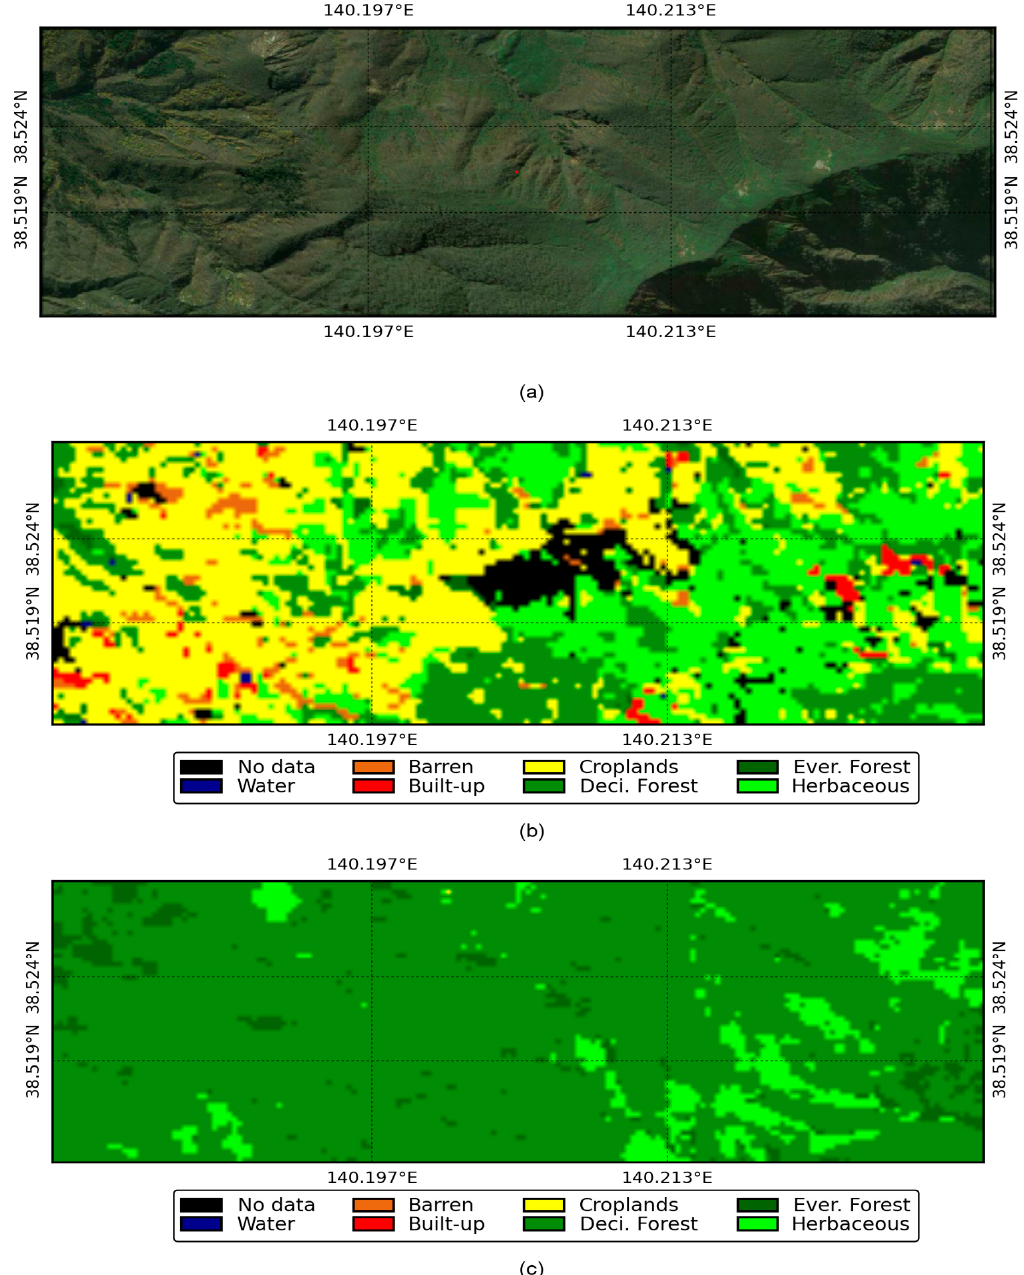
Figure 11. Performance of the JpLC-30 map over the JHR LULC map: ( a ) Google Earth™ image; ( b ) JHR LULC map; ( c ) JpLC-30 map.